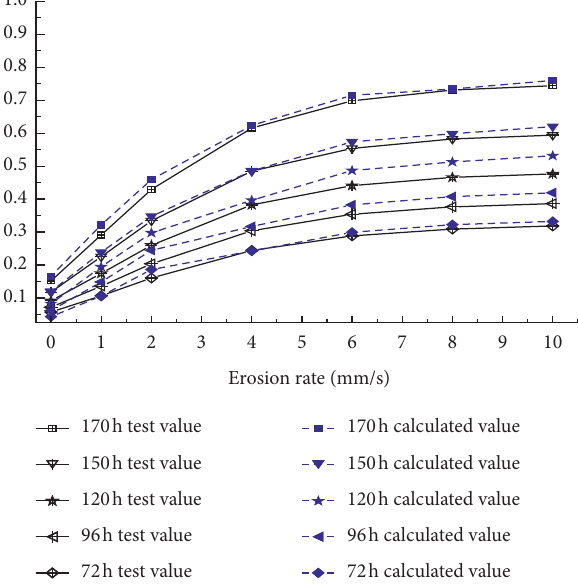
Figure 13: Variations of hydraulic gradient and time with average internal erosion